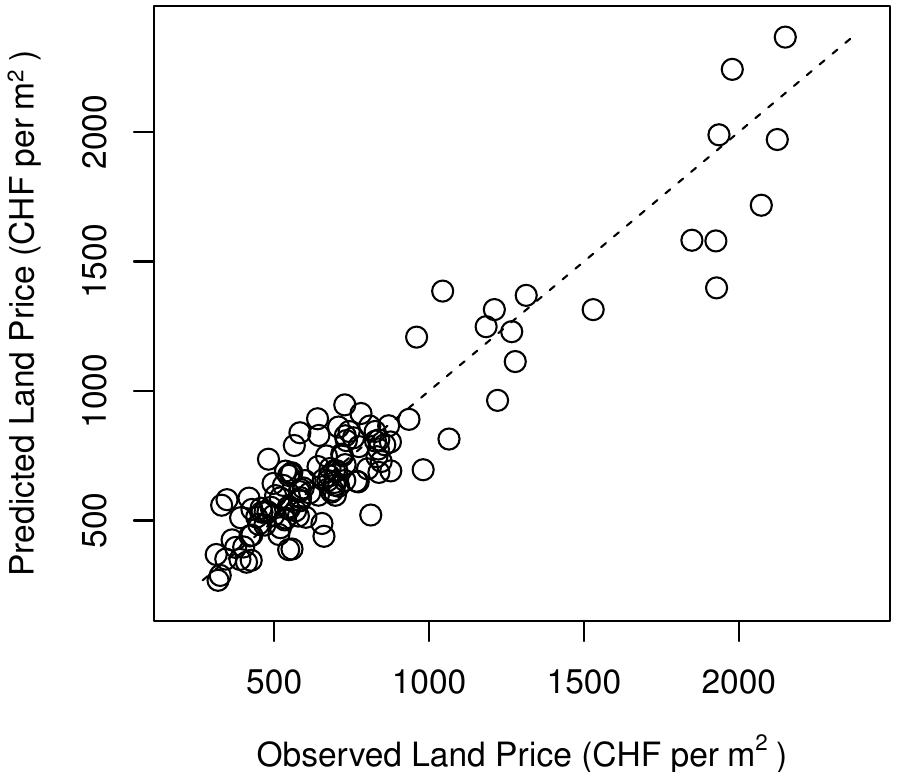
Figure 3. Predicted versus observed land transaction prices. (This figure compares the implicit relative land rents to the observed absolute mean land prices in the canton of Zurich. The predicted implicit relative land prices are the fitted values based on the estimation results from Table 1. The strong linear relationship between the predicted and actual land prices is reflected in a correlation coefficient of